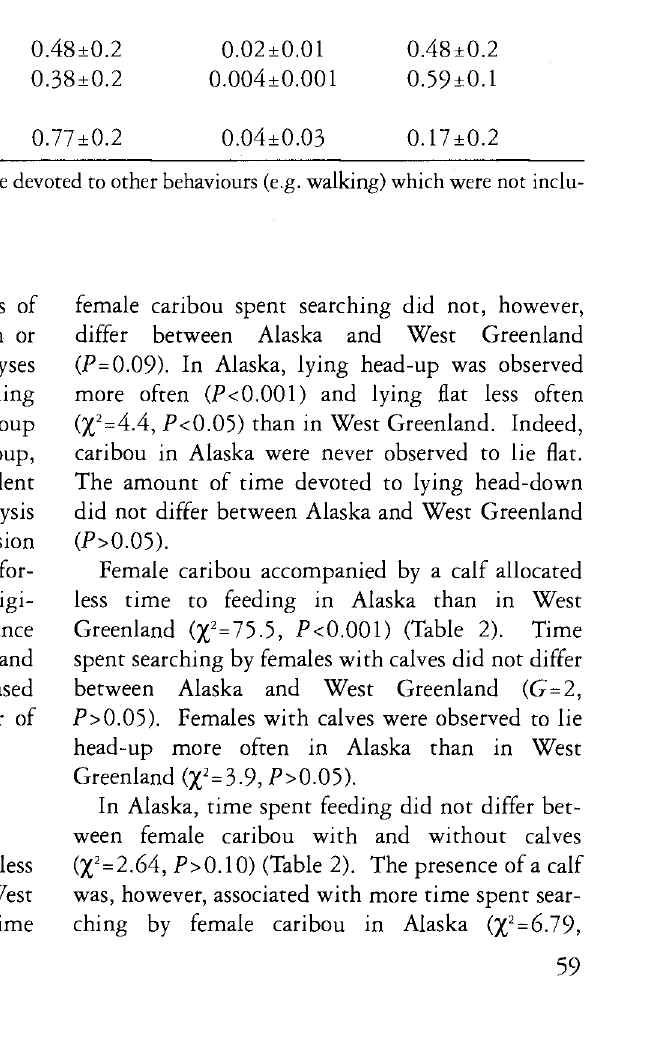
Table 2. Activity budgets of female caribou (with and without calves) of the Southern Alaska Peninsula, Alaska, USA, and Kangerlussuaq-Sisimiut, West Greenland, herds based on observations of focal animals during calving seasons in 1992 and 1993 respectively. The proportion of time devoted to each activity is given as the mean (+1 SD) of the total number of minutes devoted to each activity averaged over total number [n) of caribou